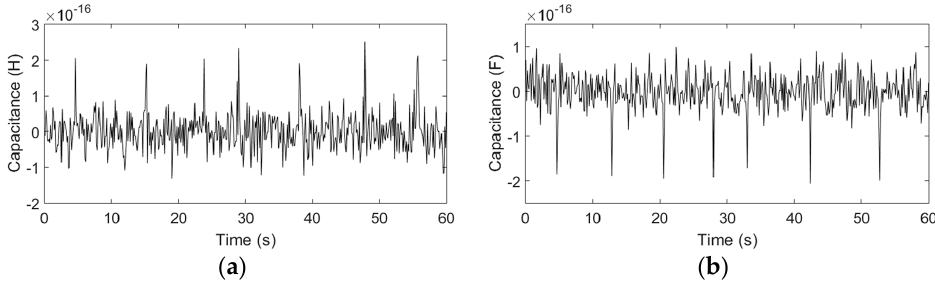
Figure 11. Detection results of water droplets and bubbles, the frequency was 0.3 MHz and each coil had 20 turns: ( a ) water droplets with sizes ranging from 100 to 110 μ m; ( b ) bubbles with sizes ranging from 180 to 200 μ m.